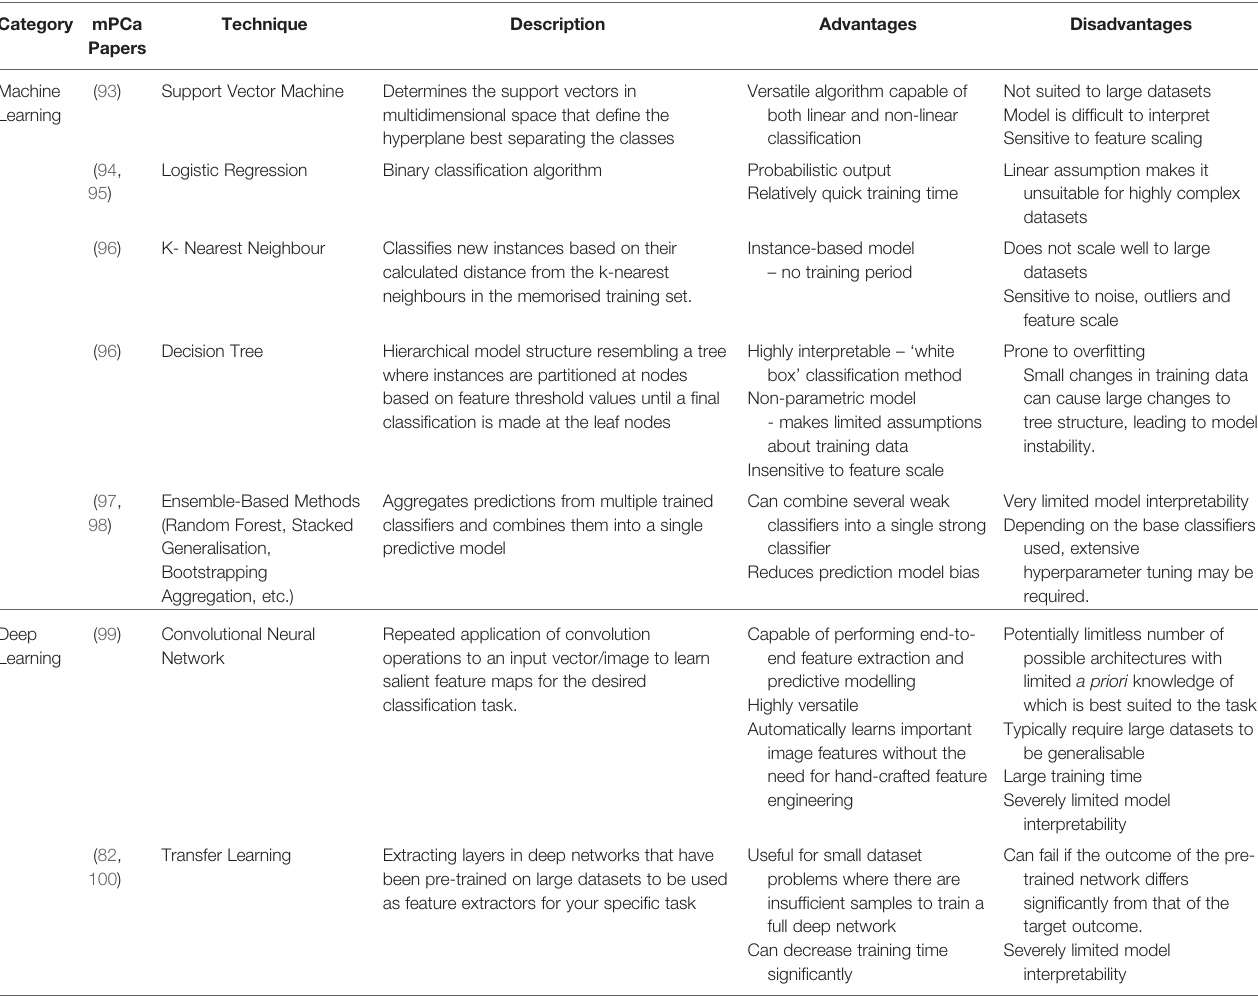
TABLE 1 | Summary of the prominent modelling techniques used in radiomics